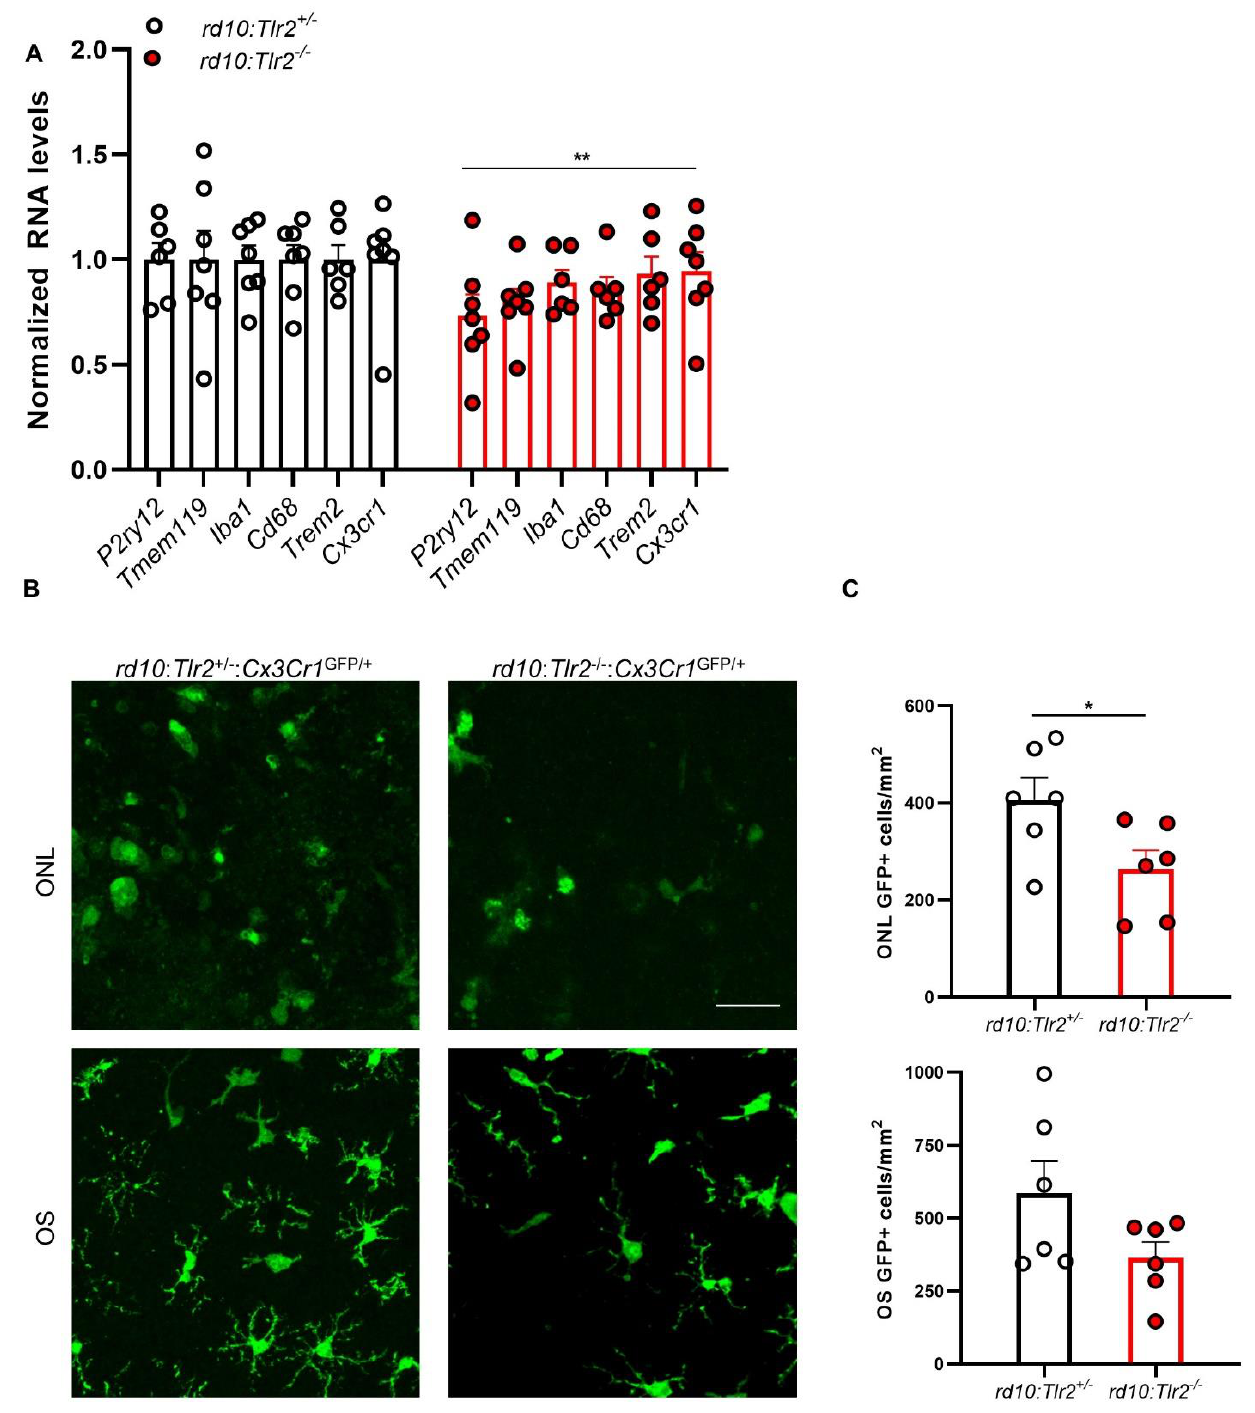
Figure 7. Myeloid cell analysis in rd10:Tlr2 +/ − and rd10:Tlr2 − / − retinas: qPCR and histology. ( A ) RT-qPCR for myeloid cell genes in rd10:Tlr2 +/ − and rd10:Tlr2 − / − retinas at P36. Transcript levels were normalized to Tbp RNA and expressed relative to rd10:Tlr2 +/ − mice (=1). Dots represent individual animals, while bars represent the mean (+SEM) for each group. n = 6–7 mice. ** p < 0.01 (2way ANOVA). ( B ) Representative confocal optical maximal projection acquired at the indicated level in wholemount retinas from P25 Cx3Cr1 GFP/+ mice. Microglial cells express GFP (green). Scale bar: 34 µ m. ( C ) Quantification of the number of GFP + cells in the OS and ONL of the mice shown in B. In all cases, dots correspond to individual animals and bars represent the mean (+SEM) for each group. OS, outer segment; ONL, outer nuclear layer. n = 6 animals. * p < 0.05 (unpaired Student’s t -test).